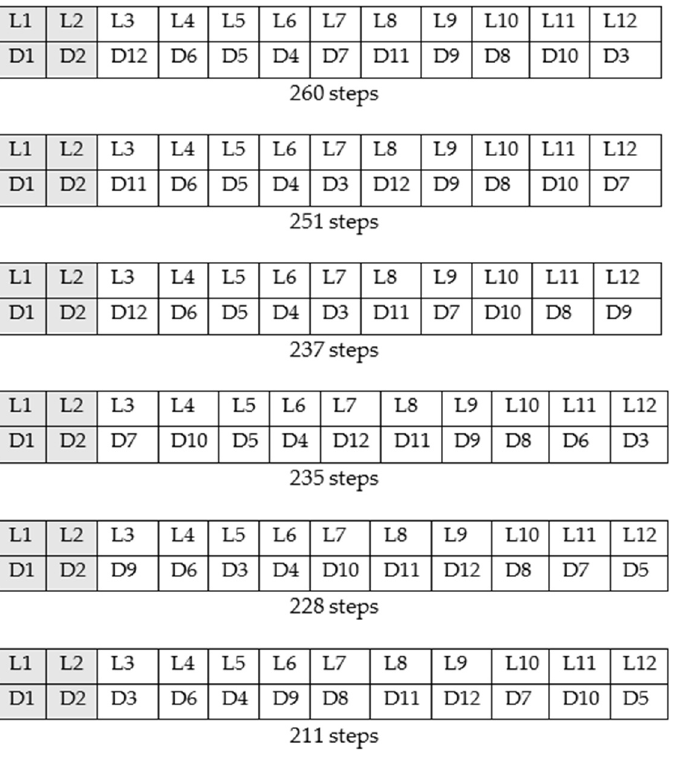
Figure 5 Layout redesigns obtained from Genetic